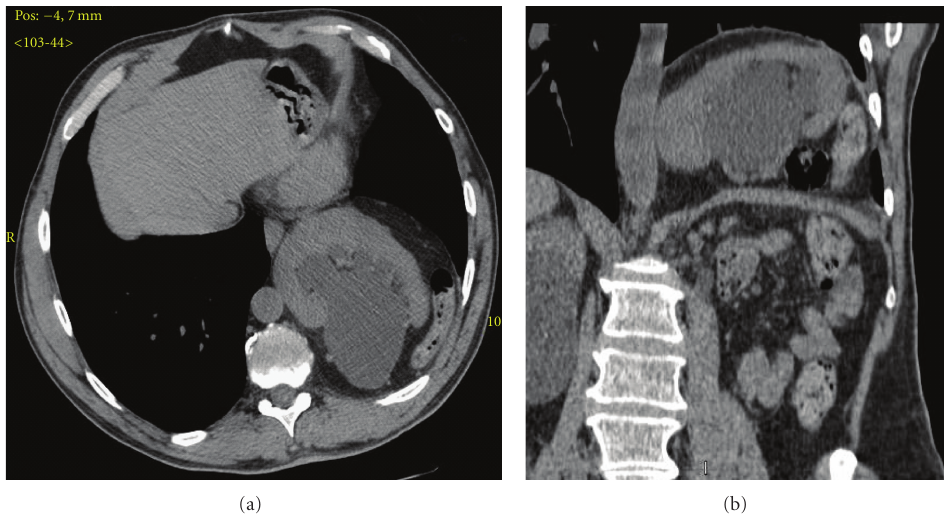
Figure 3: Basal CT (computed tomography) imaging. (a) Axial scan illustrates the left renal ectopia with renal junction expanded. (b) multiplanar reconstruction (MPR) on coronal plane confirm Bochdalech hernia.